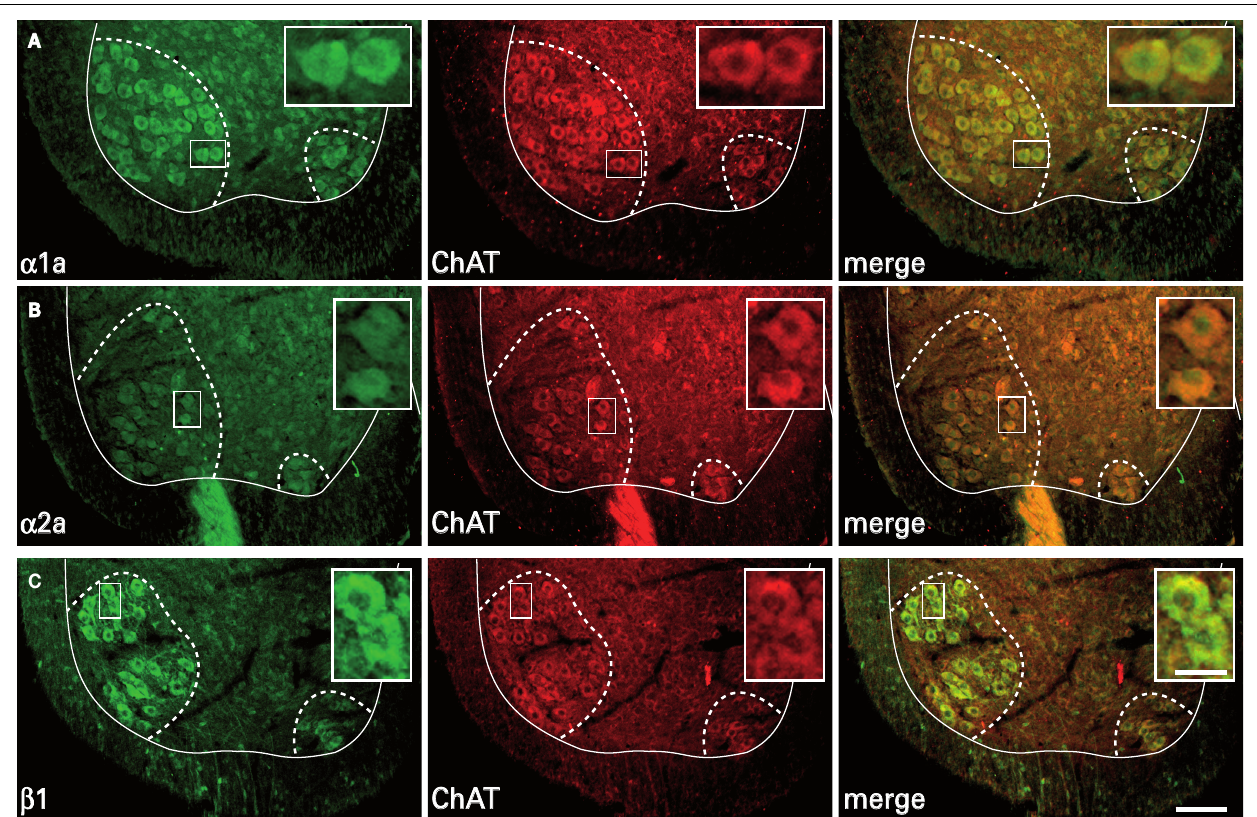
FIGURE 1 | Expression of adrenoreceptor subtypes in cholinergic neurons in transverse sections of the lumbar spinal cord. Double labeling of large neuronal cell bodies in lamina IX (dashed lines) for alpha 1a (A) ; alpha 2a (B) ; beta 1 (C) noradrenergic receptors (green) and choline acetyltransferase (ChAT,